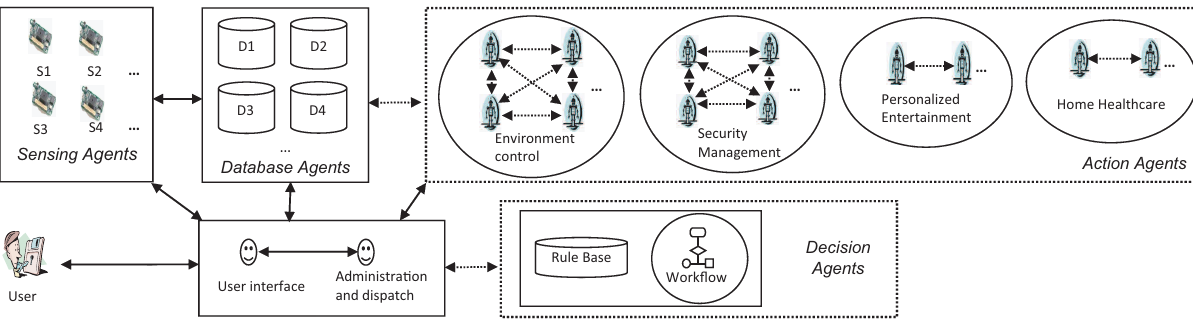
Figure 4. The proposed multi-agent system (MAS) architecture for smart house